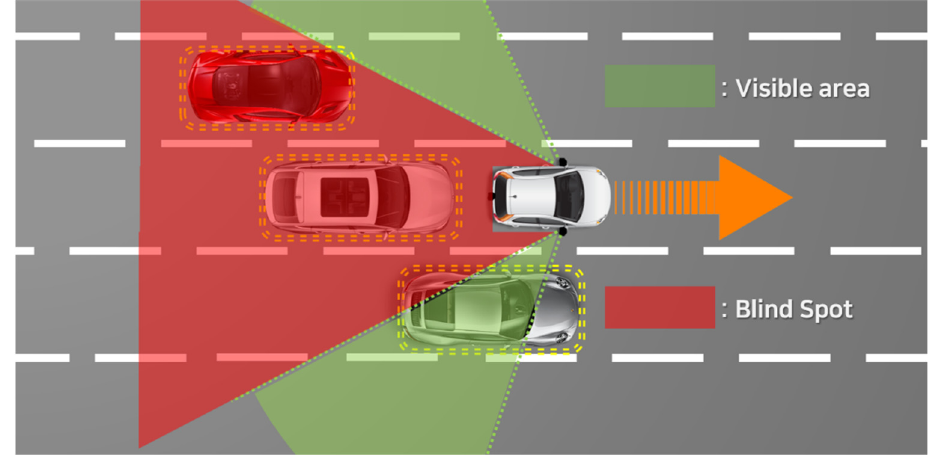
Figure 3. Blind-spot problem in micro e-mobility vehicle (MEV).